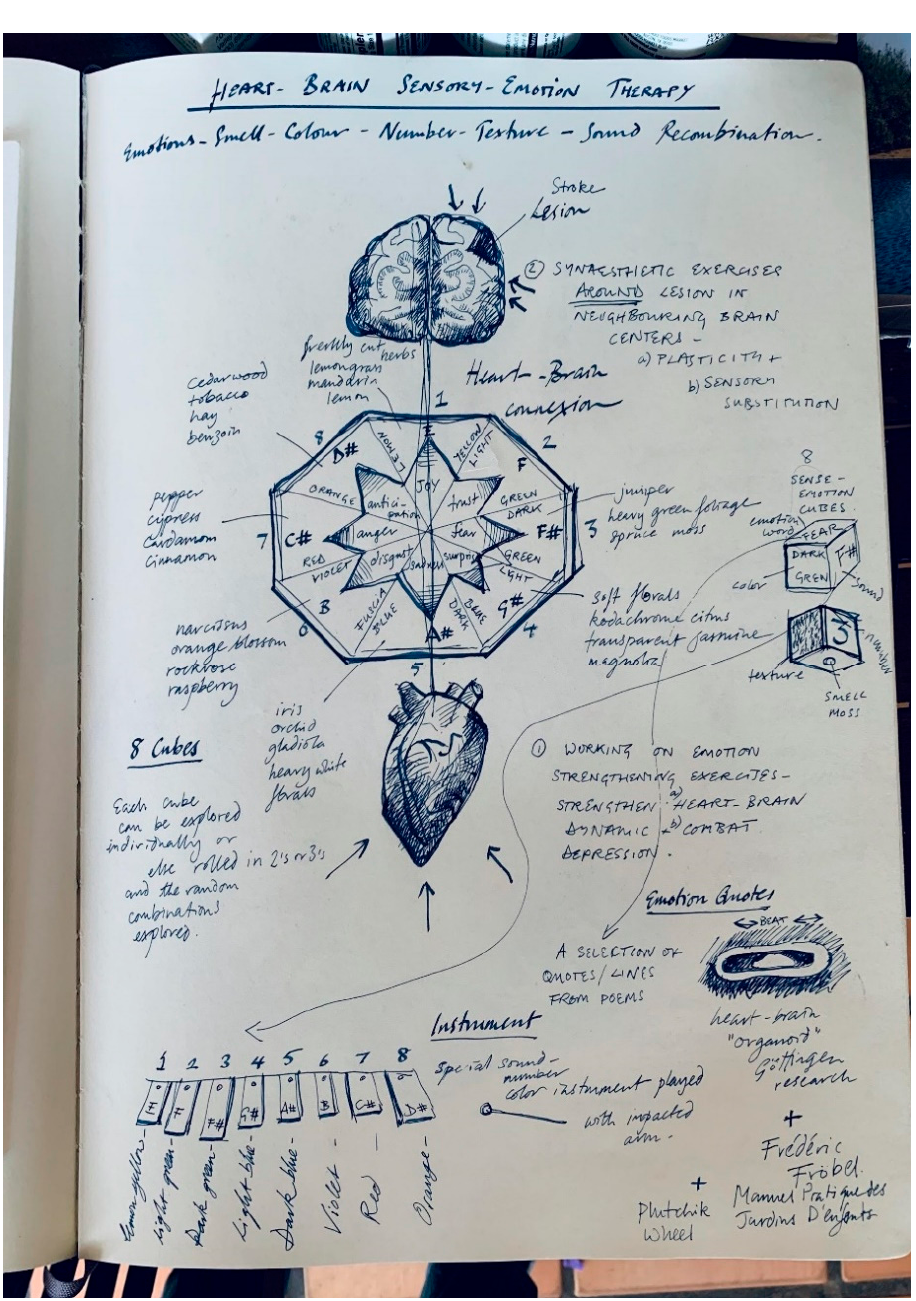
Figure 12. Preliminary exploration of synesthetic therapy ideas for Klinik.